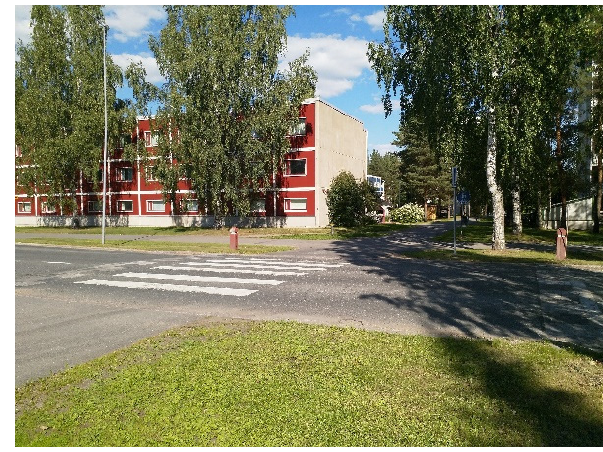
Figure 15. Conditions in spring (location 2).